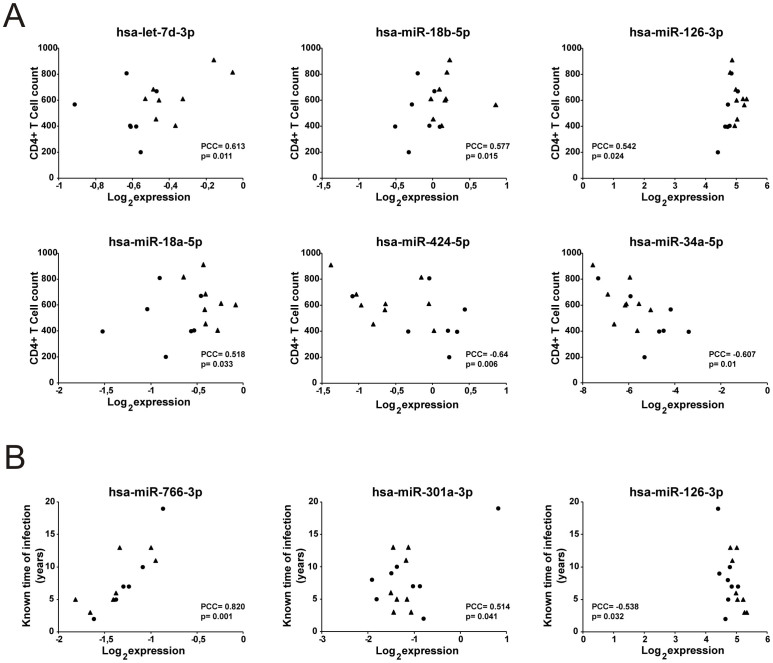
miRNAs correlated with T CD4+ cell count and known time of infection.(A) Six miRNAs were found to be correlated with T CD4+ cell count. (B) Three miRNAs were correlated with known time of infection in years. The analysis was performed considering all the HIV infected samples. PCC: Pearson correlation coefficient, p: p value. The p values indicate the significance of the Pearson correlation. •: chronic HIV, ▴: elite controllers.